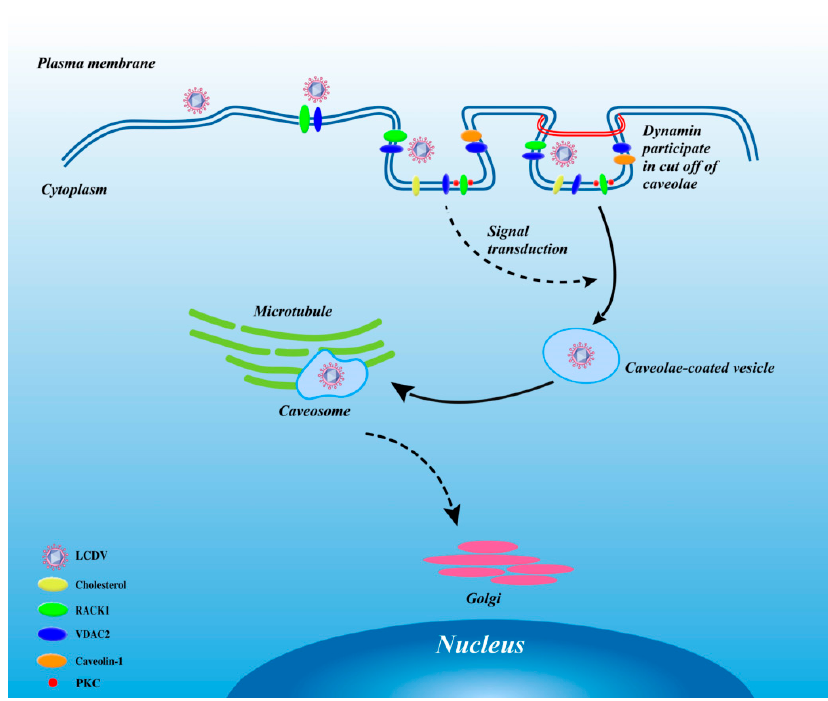
Figure 12. Model of LCDV entry via the caveolae-mediated endocytosis pathway facilitated by viral receptors. Solid arrow represented the LCDV entry steps has been proved in the present study, and dotted arrow represented potential steps basing on other published research.In conclusion, we confirmed that